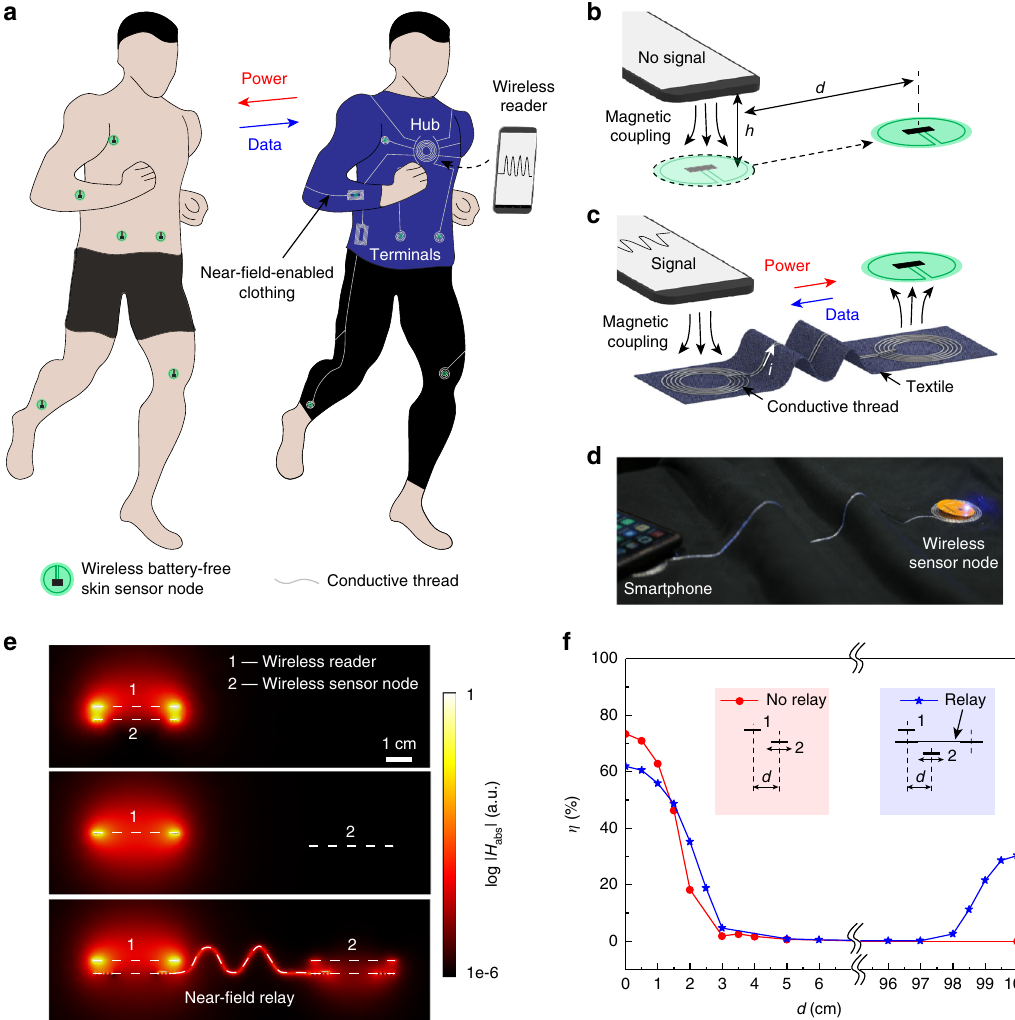
Fig. 1 Battery-free sensor networks based on near- fi eld-enabled clothing. a Illustration of multiple battery-free sensor nodes mounted on the skin and interconnected to a wireless reader through the near- fi eld-enabled clothing. b , c Conventional near- fi eld communication ( b ) is limited to at most a few centimetres separation between the reader and sensor, while near- fi eld relays ( c ) enable near- fi eld connectivity upto metre scale in separation. h is vertical distance, d lateral distance, and i current. d Photograph of a smartphone wirelessly powering a sensor node over a relay (40 cm length). e Normalised magnetic fi eld ∣ H abs ∣ generated by a reader directly above a sensor, reader offset from sensor, and reader interconnected to sensor by a near- fi eld relay. Reader and sensor diameters are 3.1 cm and distances h = 0.5 cm and d = 8 cm. f Power transfer ef fi ciency η as a function of sensor position d relative to the reader without (red) and with (blue) a relay (1 m length). η < 1% in the concatenated